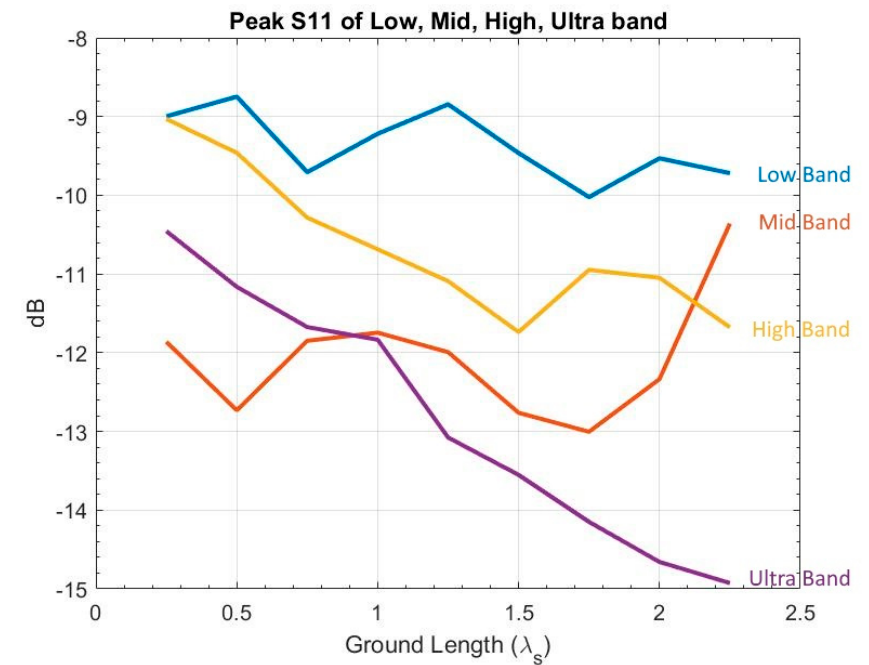
Figure 8. Variation of ground length (blue: low band, red: mid band, yellow: high band, purple: ultra band).